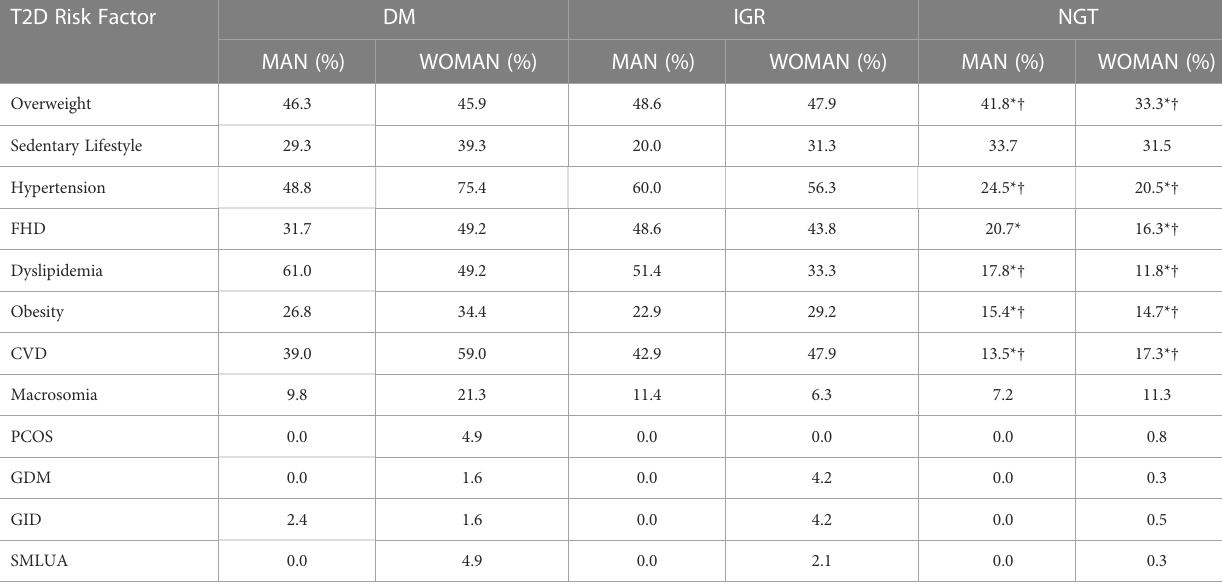
TABLE 2 Rank of prevalence of T2D risk factors (on the basis of NGT men